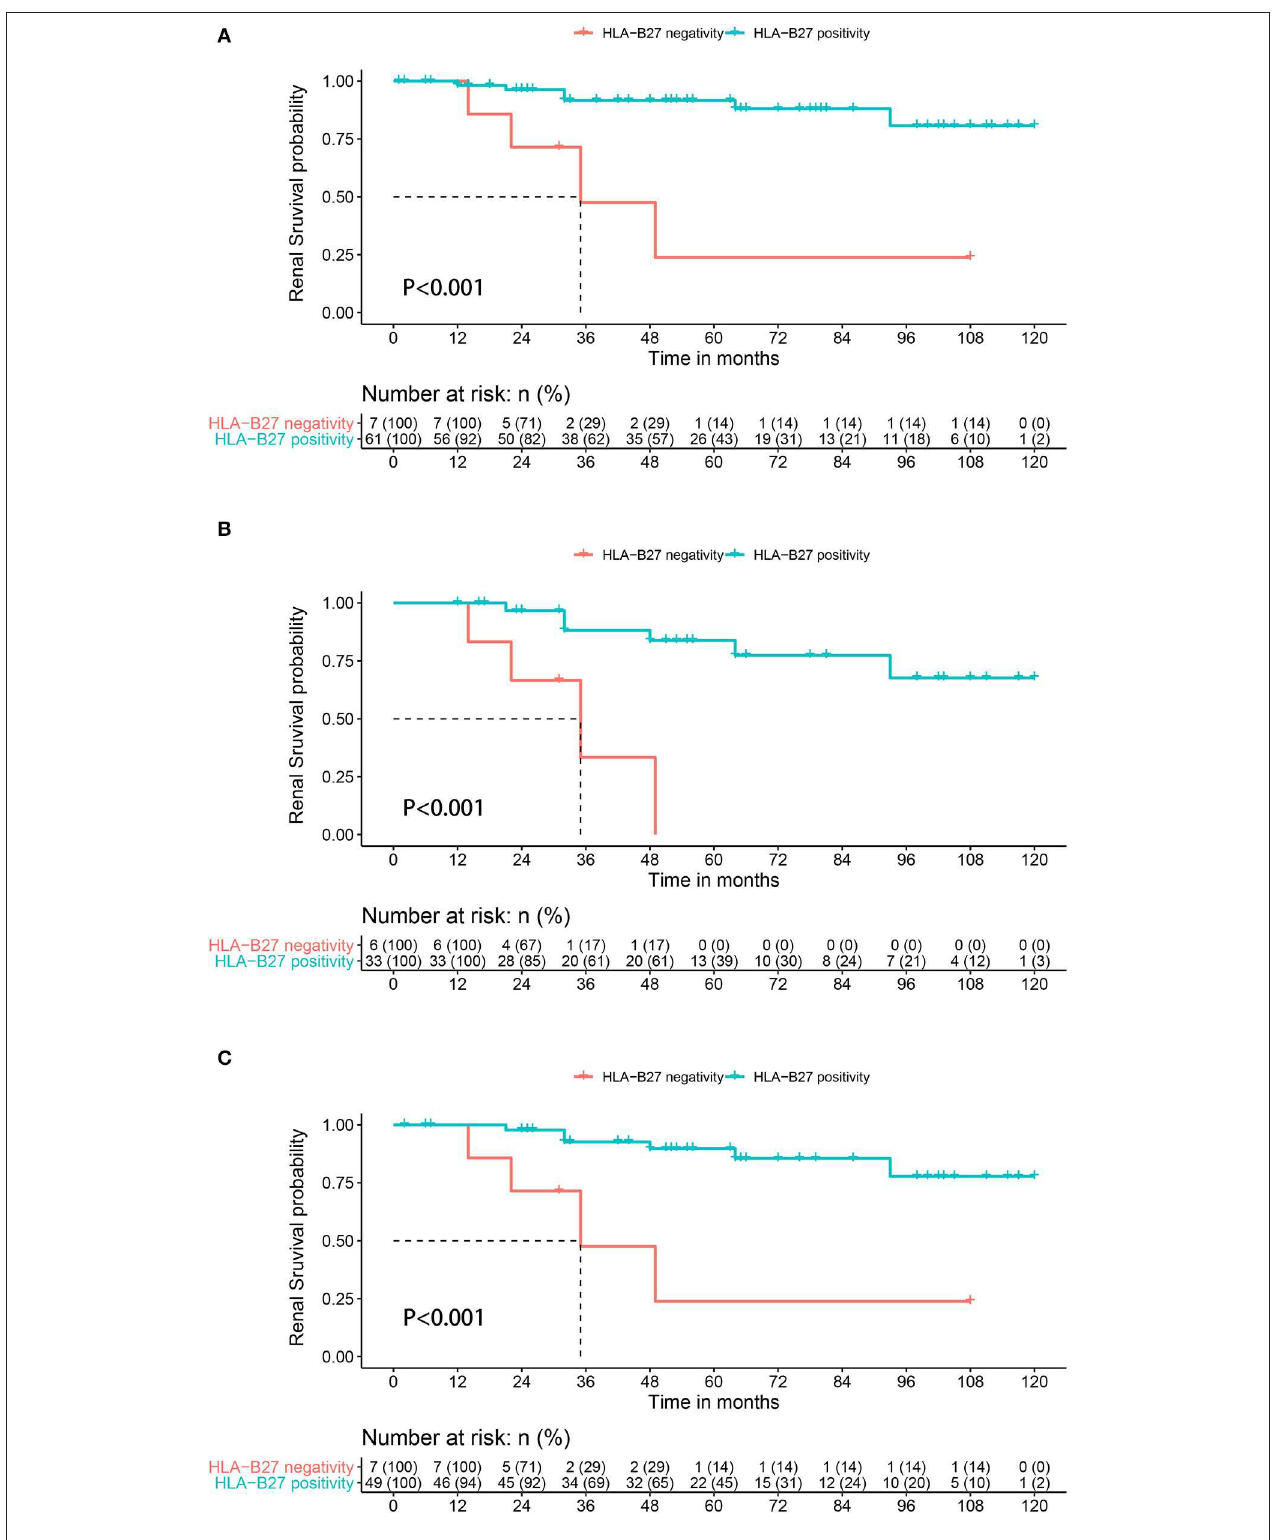
FIGURE 1 | Kaplan-Meier survival plots for renal function decline during follow-up depending on the presence or absence of HLA-B27 in AS patients with IgAN (A) whole population, (B) in the subgroups of patients with proteinuria at >1.0g per day, and (C) in the subgroups of patients with interstitial fibrosis and tubular atrophy.